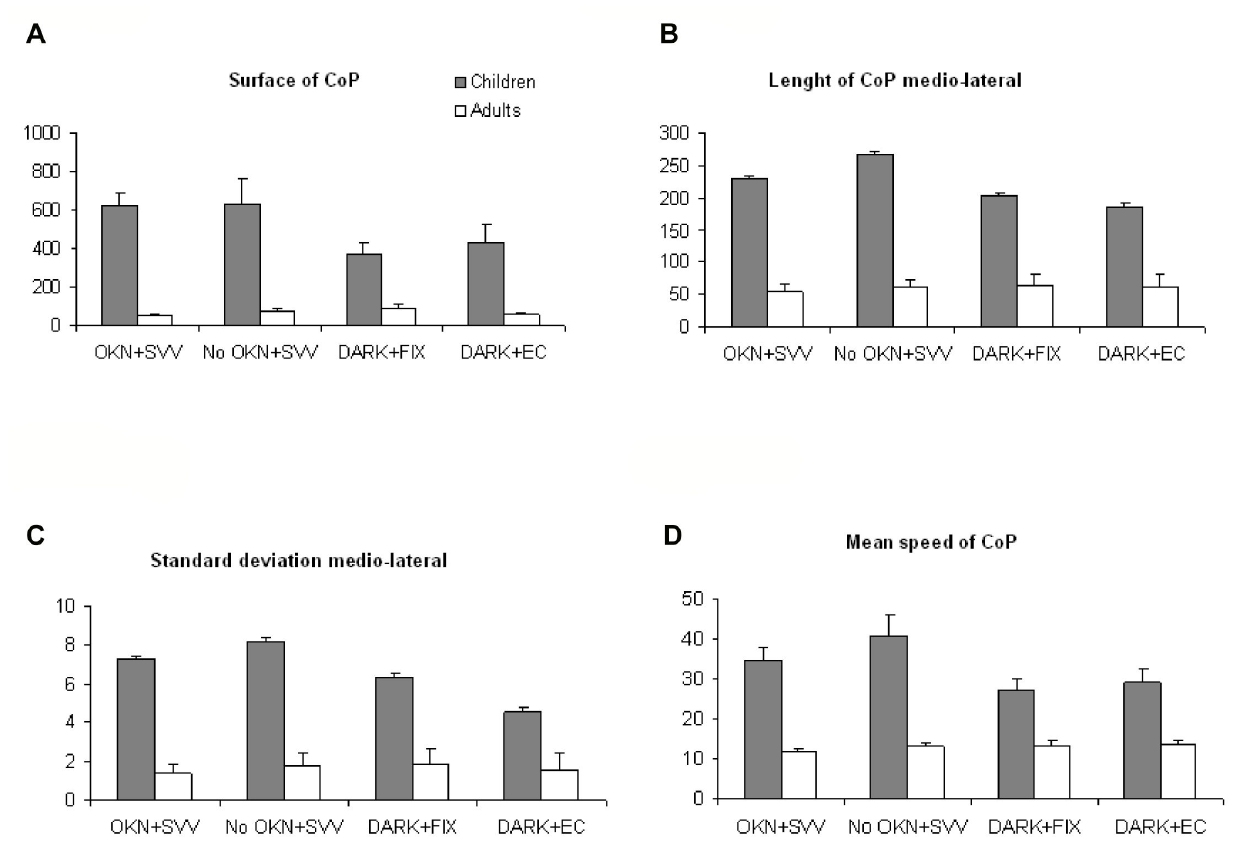
Figure 3. Postural parameters for the different conditions. Mean of Surface of CoP (A), of length of CoP in the medio-lateral axis (B), of standard deviation of medio-lateral body sway (C) and of mean speed of CoP (D) for the four different conditions (OKN +SVV, No OKN+SVV, DARK+FIX and DARK+EC) for adults and children. Verticals bars indicate the standard error. doi: Standard deviation of medio-lateral body sway. 3C shows the standard deviation of medio-lateral body sway